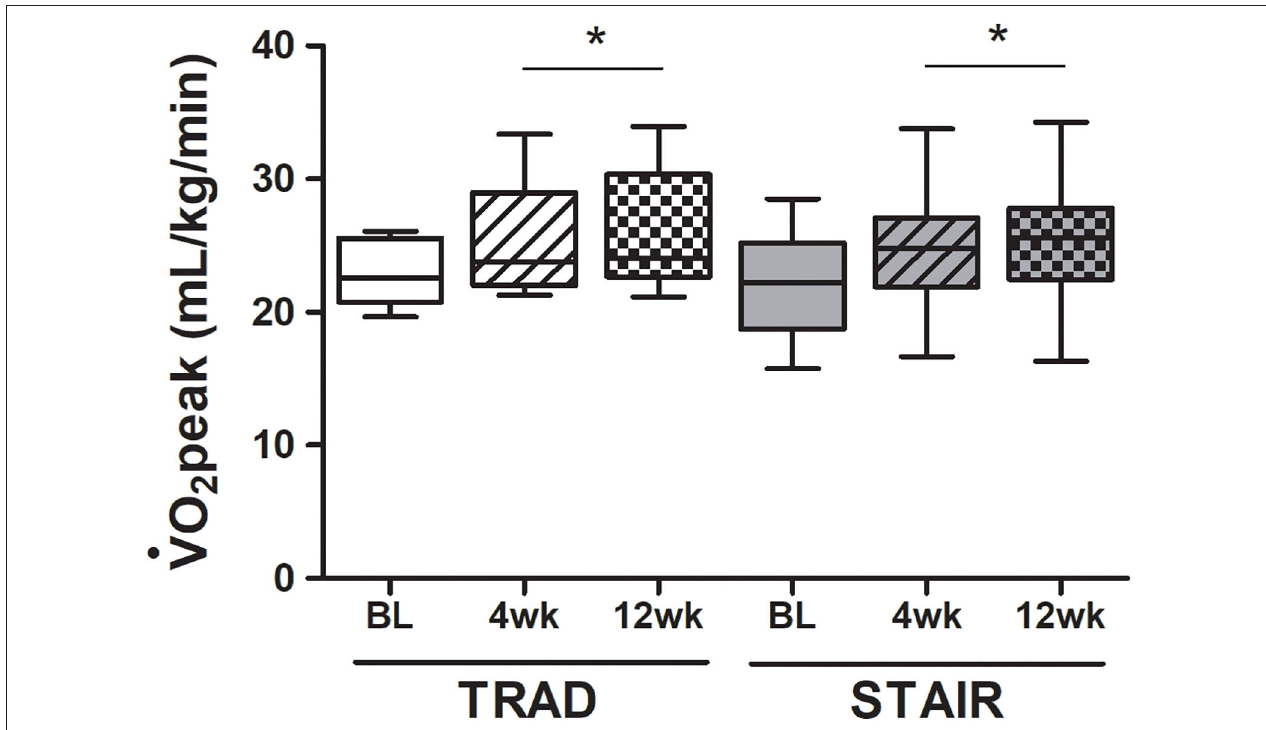
FIGURE 3 | ˙ VO 2 peak improvements following 4 weeks of supervised and 8 additional weeks of unsupervised exercise training of both TRAD and STAIR programs. Data is reported as a boxplot with the minimum, median and maximum values represented ( n = 9/group). BL, Baseline; *significantly different from Baseline ( p = 0.001), using a Two-way repeated measures ANOVA.